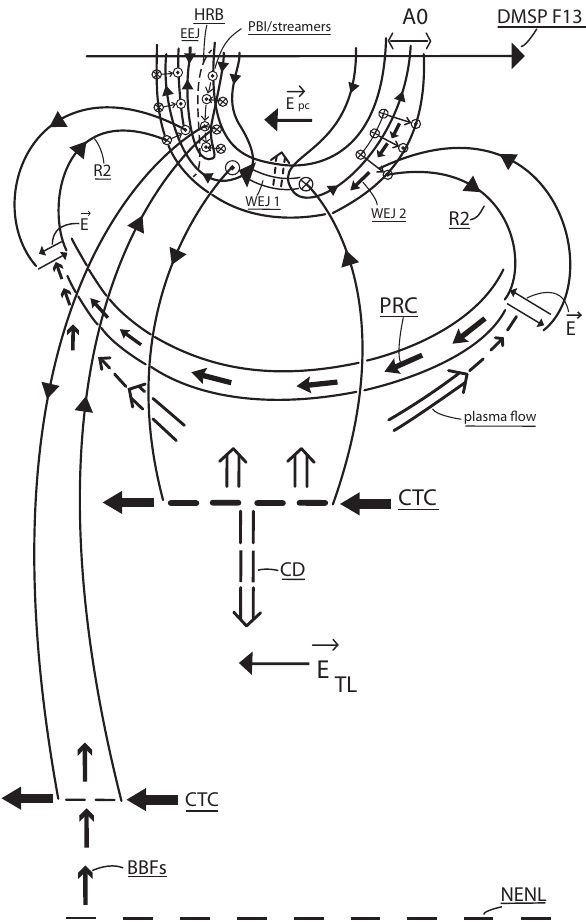
Figure 1. Schematic illustration showing four different channels of M–I coupling operating during substorm activity: (i) auroral oval around midnight (westward electrojet: WEJ) to near-Earth plasma sheet (Bostrøm type I: large-scale SCW), (ii) auroral oval south at dawn/dusk to PS–PRC boundary (Bostrøm type II), (iii) auroral oval north at dusk to midtail PS (Bostrøm type I: current wedgelet), and (iv) electric field (potential) coupling along open field lines between the polar cap ionosphere and the lobes of the magnetotail. See text for